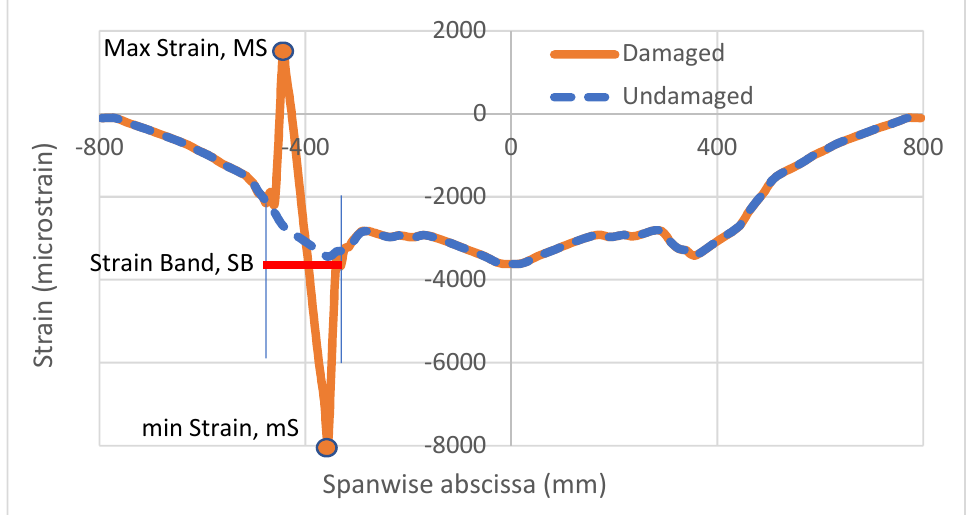
Figure 12. Strain deviation parameters, [36].